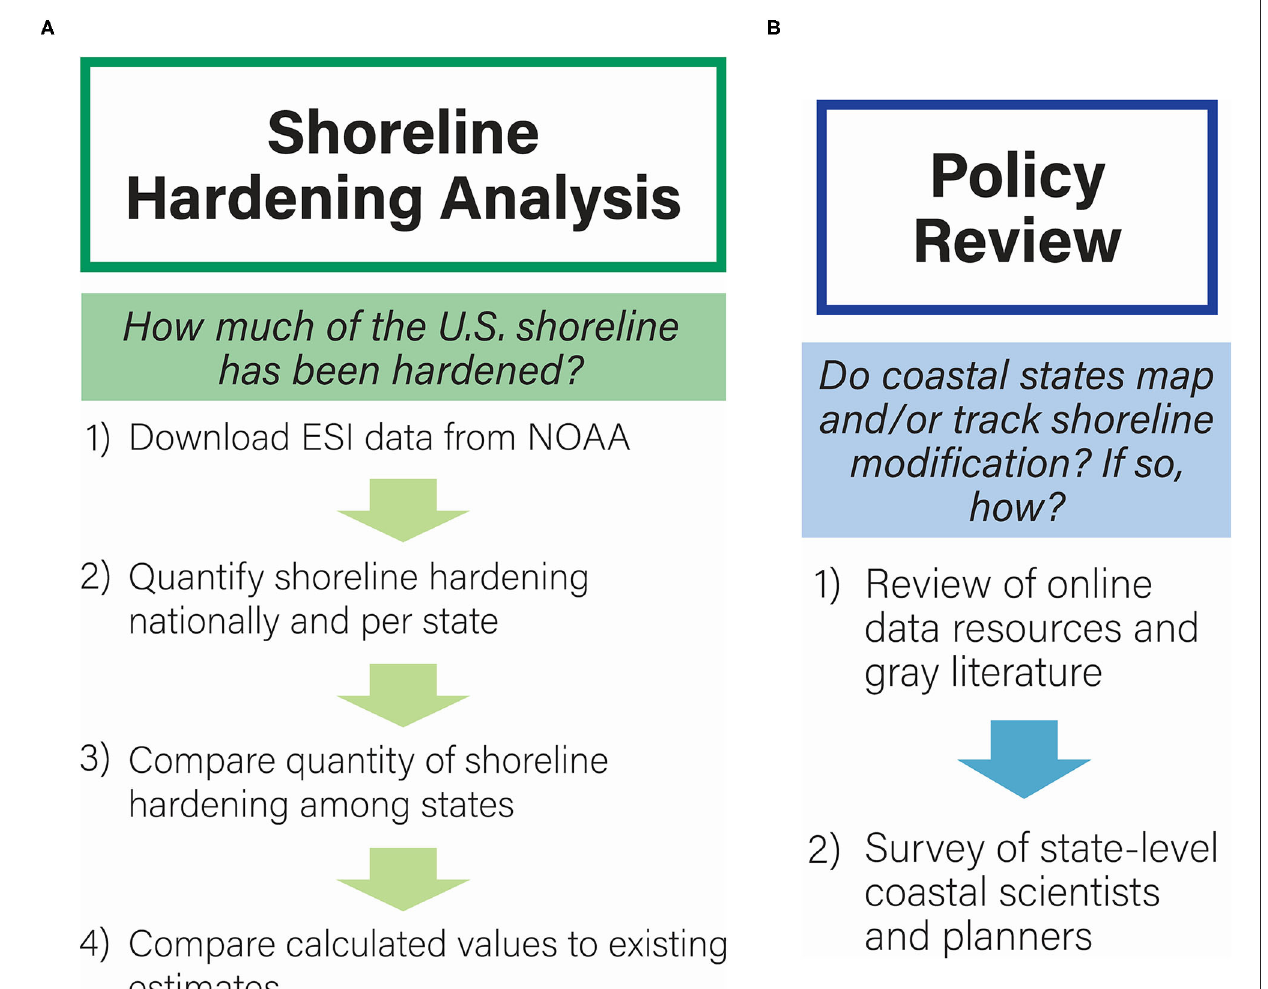
FIGURE 1 | Conceptual diagram outlining the steps used to (A) estimate the total (length) and proportion of hardened shoreline to total shoreline for each coastal state based on NOAA ESI data; and (B) conduct the state-by-state shoreline mapping